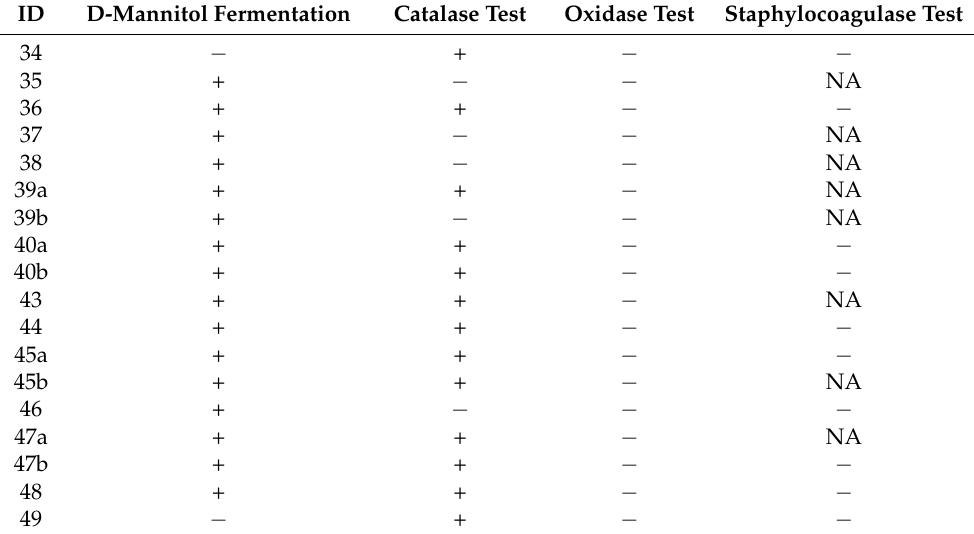
* +: positive; * − : negative; ** NA: not applicable. 3.2. Identification of Bacterial Species Recovered from Wild Boars From a total of 42 Gram-positive isolates, 15 belonged to Staphylococcus spp. (35.7%) and were all CoNS, whereas 16 belonged to Enterococcus spp. (38.1%) (Figure 1). However, on MSA, we detected the growth of other Gram-positive bacteria such as Macrococcus spp. (9.5%; 4/42 strains) and Bacillus spp. (16.7%; 7/42 strains), which were identified with lower frequency values as represented in Figure 1.